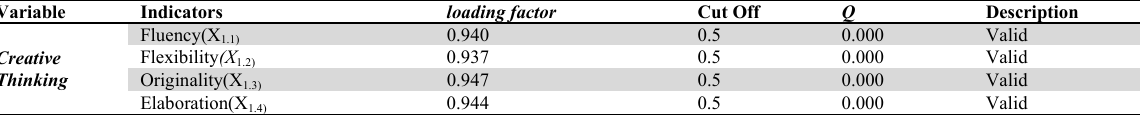
Coefficient Value loading factor For Creative Thinking